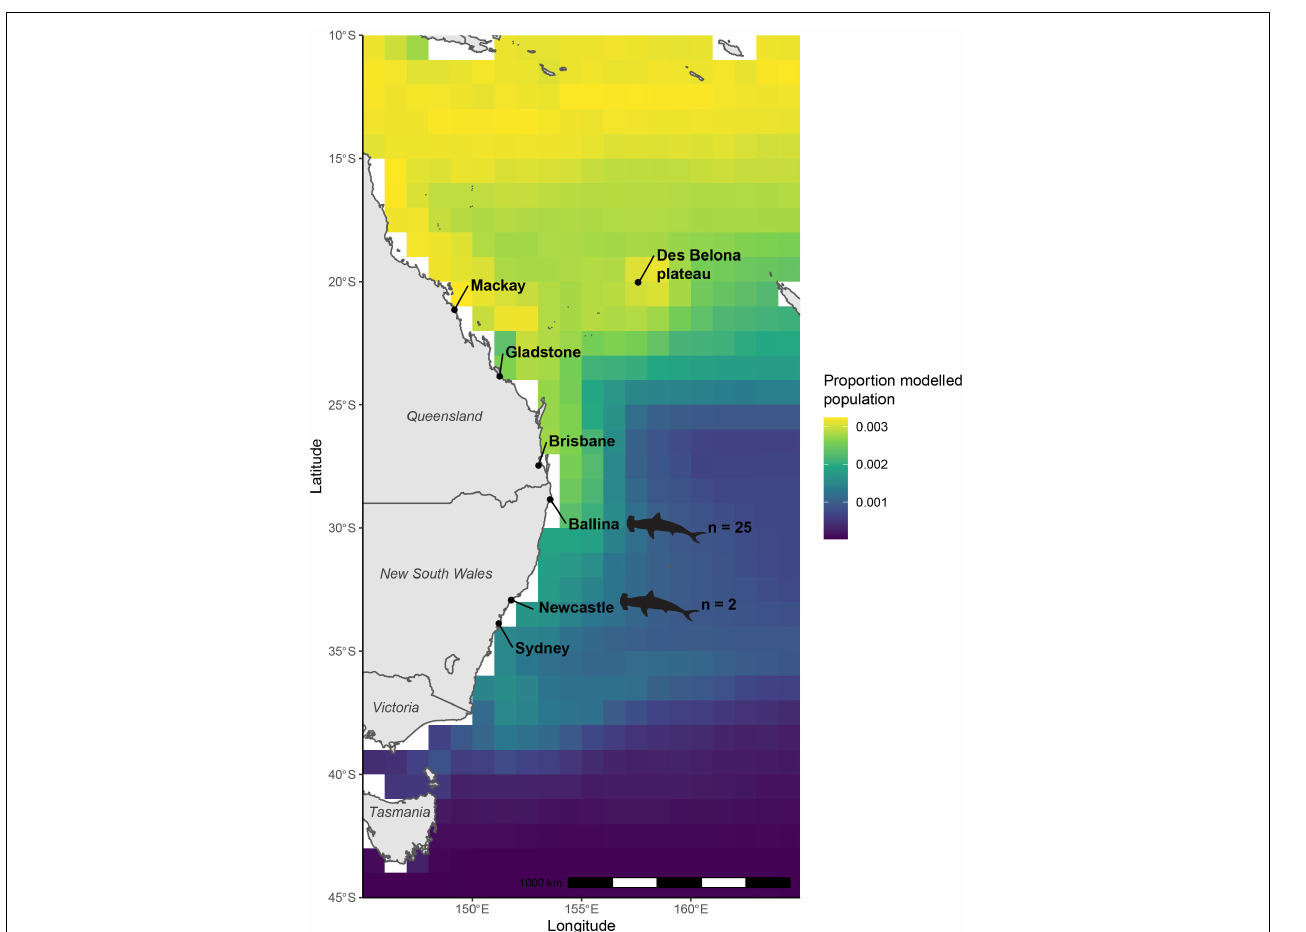
FIGURE 4 | Modeled population geographic range of great hammerhead sharks ( Sphyrna mokarran ) inferred from δ 13 C stable isotope values of muscle tissues of great hammerhead sharks and biomass-weighted annual median δ 13 C plk values of oceanic phytoplankton extracted from NEMO-MEDUSA framework. Locations where great hammerhead shark samples were collected are indicated by shark